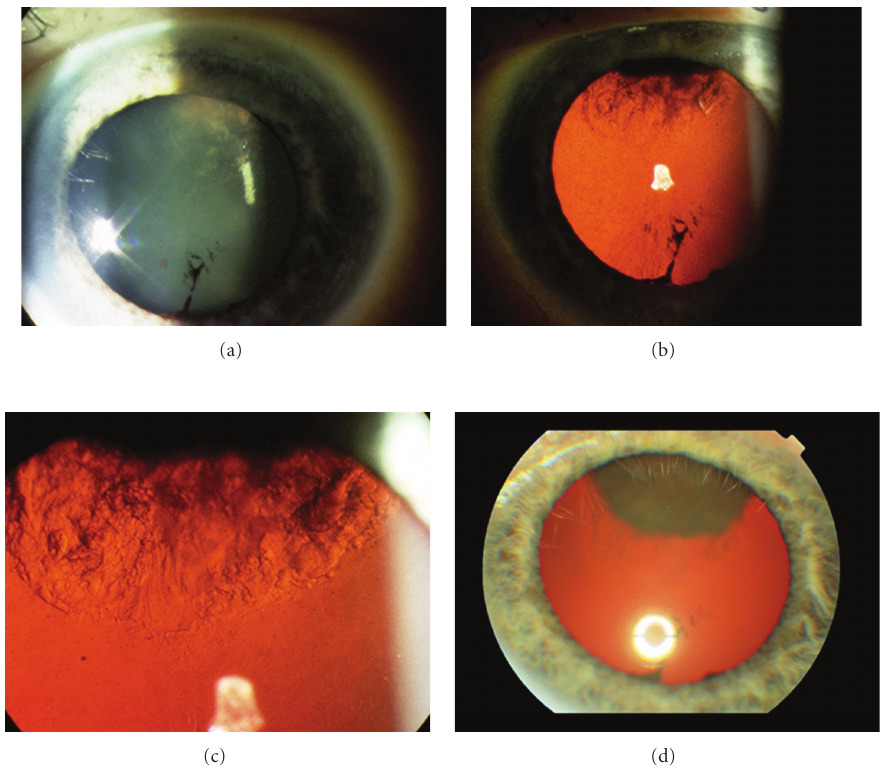
Figure 4: Ciliary body melanoma extending to the lens causing localized cataract.